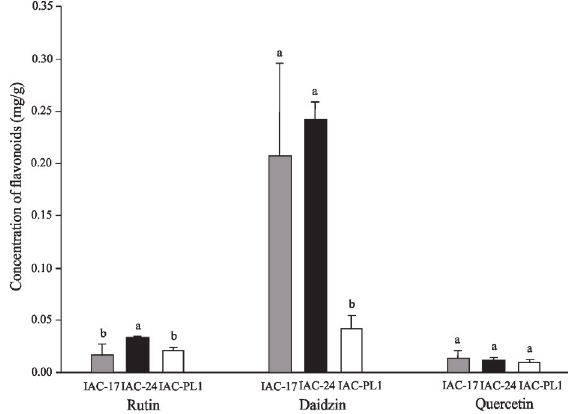
Figure 3 - Flavonoids concentrations in the insect resistant soybean cultivars IAC-17 and IAC-24 and susceptible IAC- PL1 24h after, mechanically damaged. Means followed by the same letter are similar between them by Tukey test (p<0.01) (Rutin p = 0.027, Daidzein p =0.007, Quercetin p>